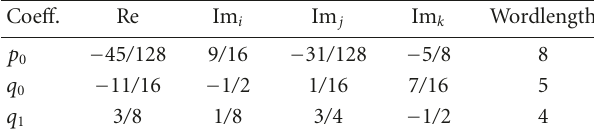
Table 1: Rational coe ffi cient values for general PUFB. Coe ff